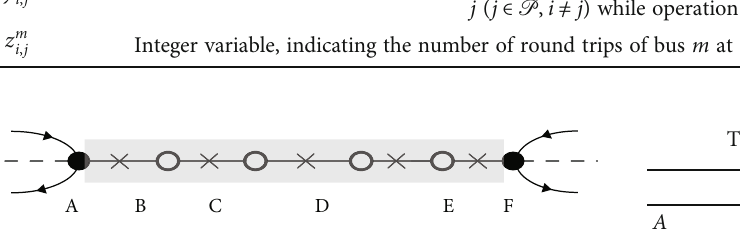
Figure 6: Topology of a disruptive event in Shanghai URT line 9. Table 4: Passenger demand between two stations.